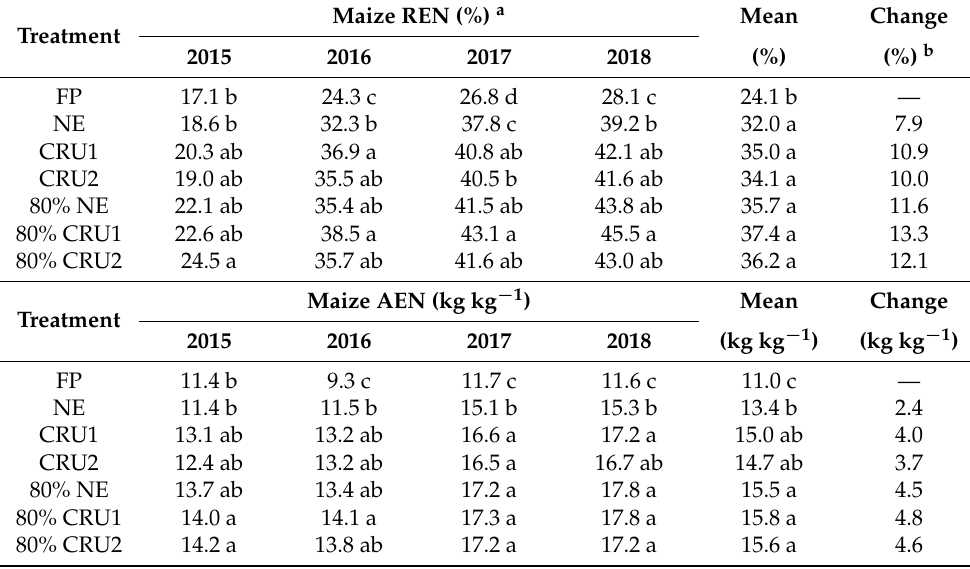
a Values followed by different letters in the same column for different treatments are significantly different at the 0.05 probability level. REN is the recovery efficiency of N fertilizer application, AEN is the agronomic efficiency of N fertilizer application. b Compared with FP.